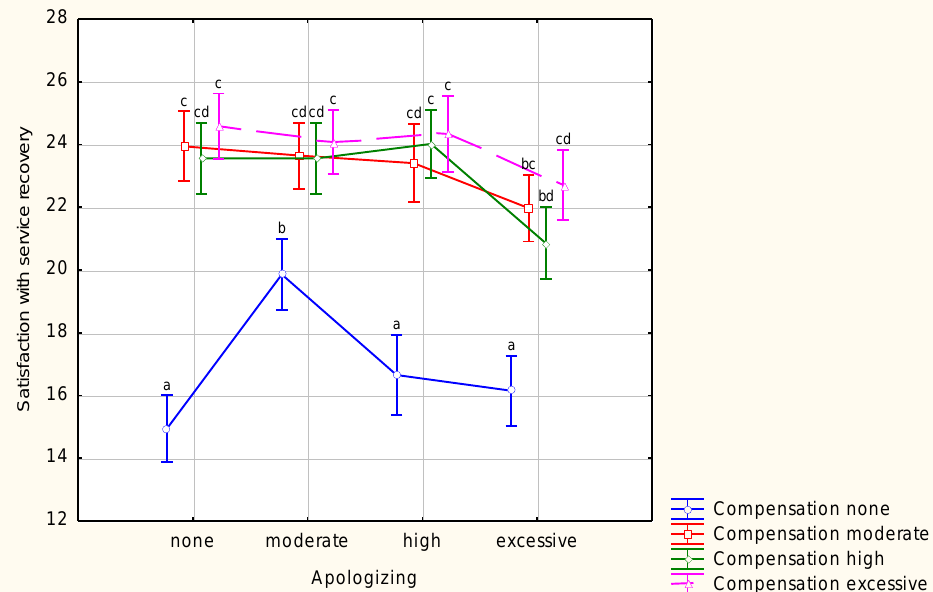
Figure 2: A LS means graph of satisfaction with service recovery at different levels of compensation and apologising: Study